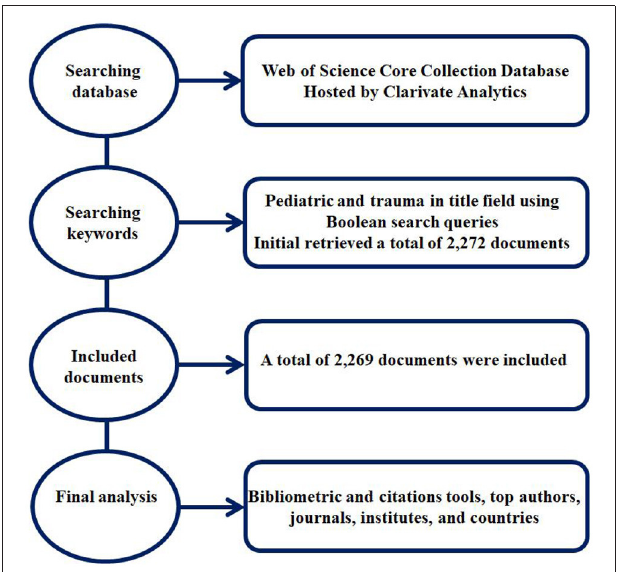
FIGURE 1 | Flow chart of documents used in the final analysis.